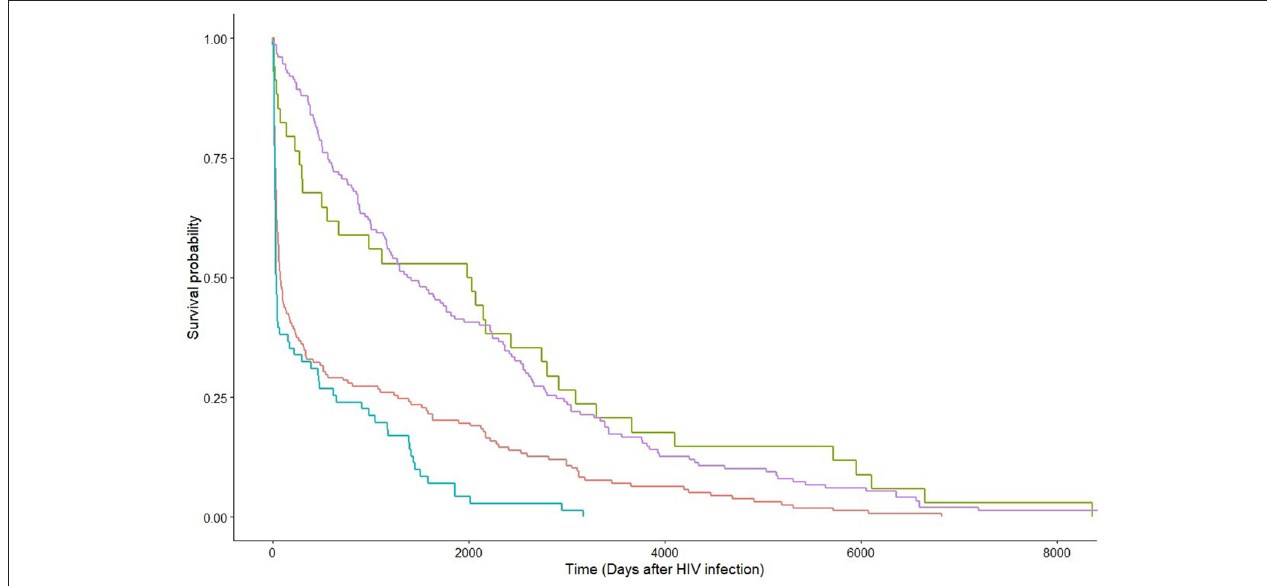
FIGURE 3 | Kaplan-Meier estimates by HIV viral suppression status at HCV diagnosis within strata of route of transmission. Green and red lines are non-MSM with and without HIV viral suppression at HCV diagnosis, respectively; whereas purple and blue lines are MSM with and without HIV viral suppression at HCV diagnosis,